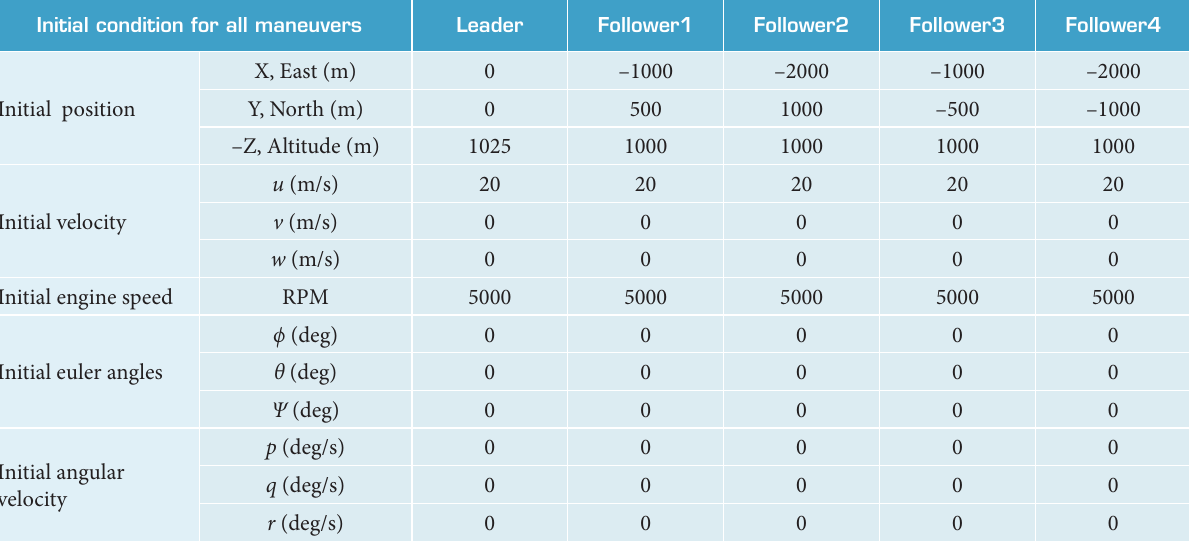
Table 4. Leader and followers initial condition for all maneuvers.